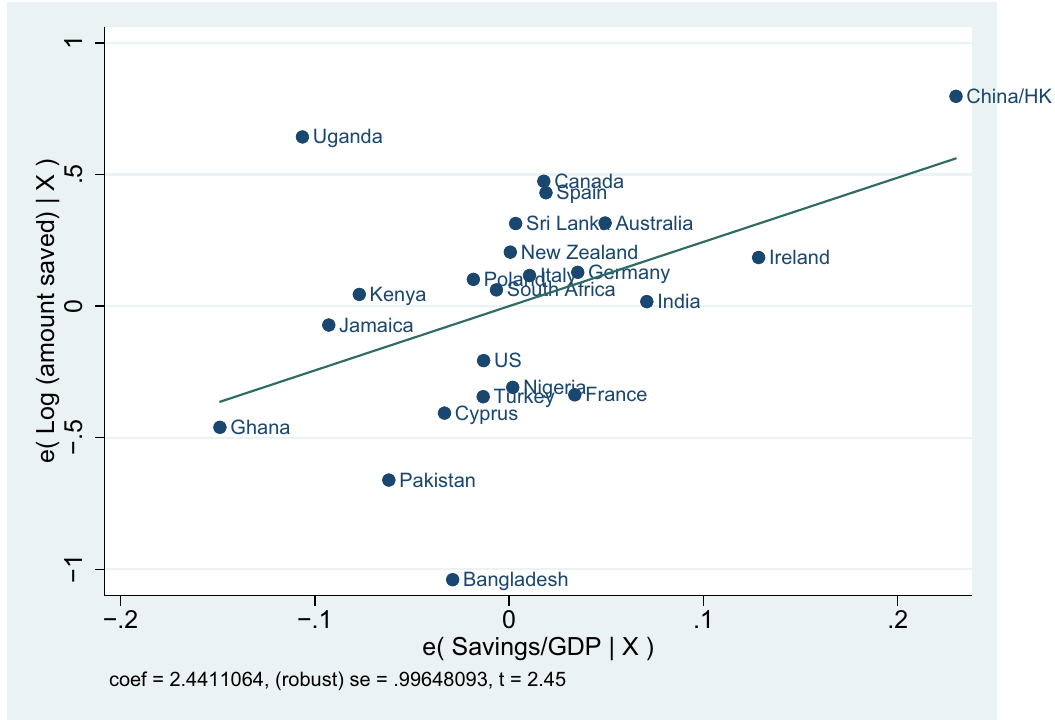
Fig 2. Partial correlation plot: Log (amount saved) for second generation immigrants. Log (amount saved) for second generation immigrants is the log of the self-reported monthly amount of saving divided by the net monthly household income. The saving rate in the countries of origin indicates the average gross domestic savings over GDP from